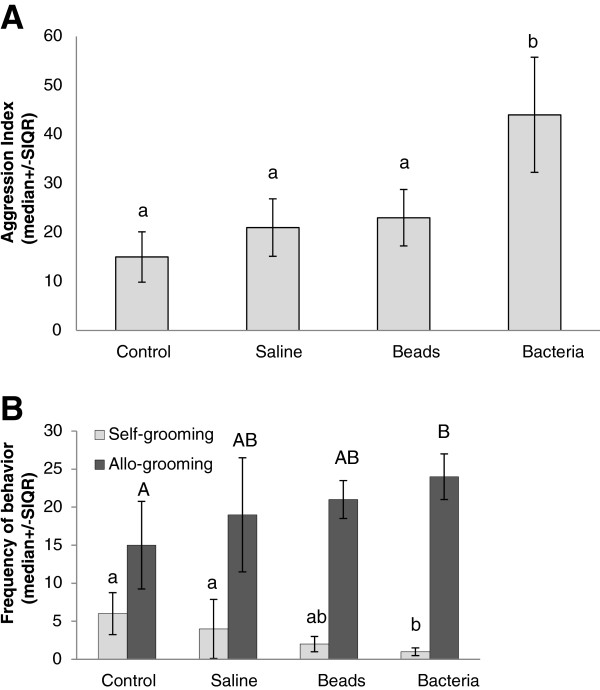
Effects of immunostimulation on behavioral interactions. A) Workers are more aggressive towards bacteria-injected nestmates. Behavioral responses of worker bees to treated nestmates were assayed using a caged nestmate recognition assay with bees from Colony 1. Data represents the median ± SIQR aggression index. The number of replicates/treatment is 15 control, 13 saline-, 18 bead-, and 19 bacteria-injected individuals. There were significant differences in behavioural responses across the four treatment groups (H(3)=29.3; p<0.001). Significant differences in post-hoc pairwise comparisons (p<0.05) are denoted by different letters. B) Workers engage in more allo-grooming of bacteria-injected nestmates. There were significant differences in allo-grooming of bees in the four treatment groups (H (3, N= 65) =7.97 p =0.046). Significant differences in post-hoc pairwise comparisons (p<0.05) are denoted by different letters.